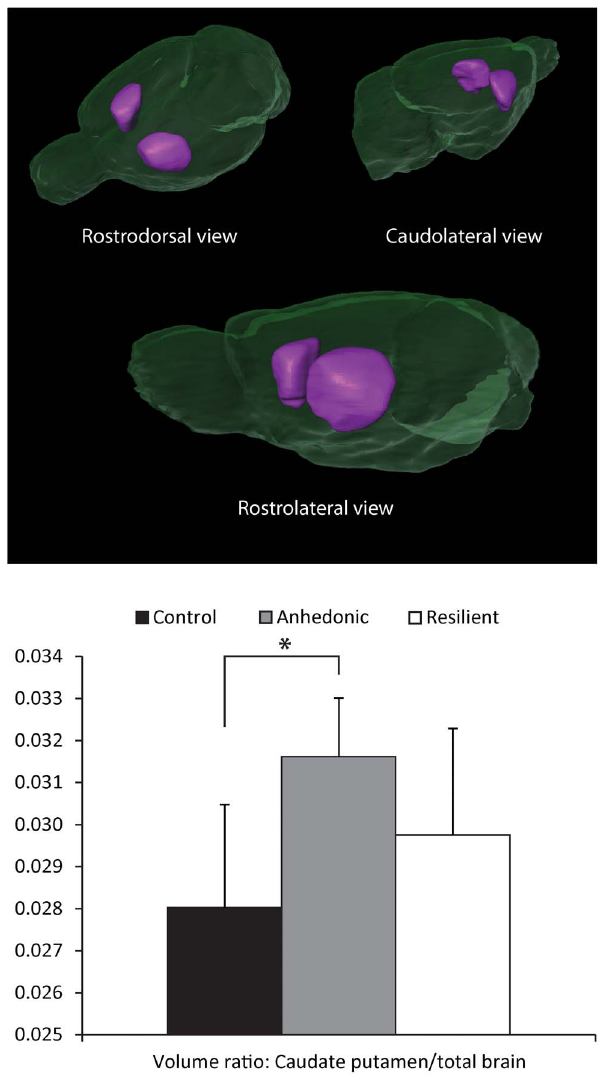
Figure 5. Results of the volume analysis of the caudate putamen. Top: Surface rendered MR images of the brain (green) and the caudate putamen (purple). Bottom: The caudate putamen/total brain ratio is enlarged in anhedonic-like animals as compared with control animals. *p , .05.